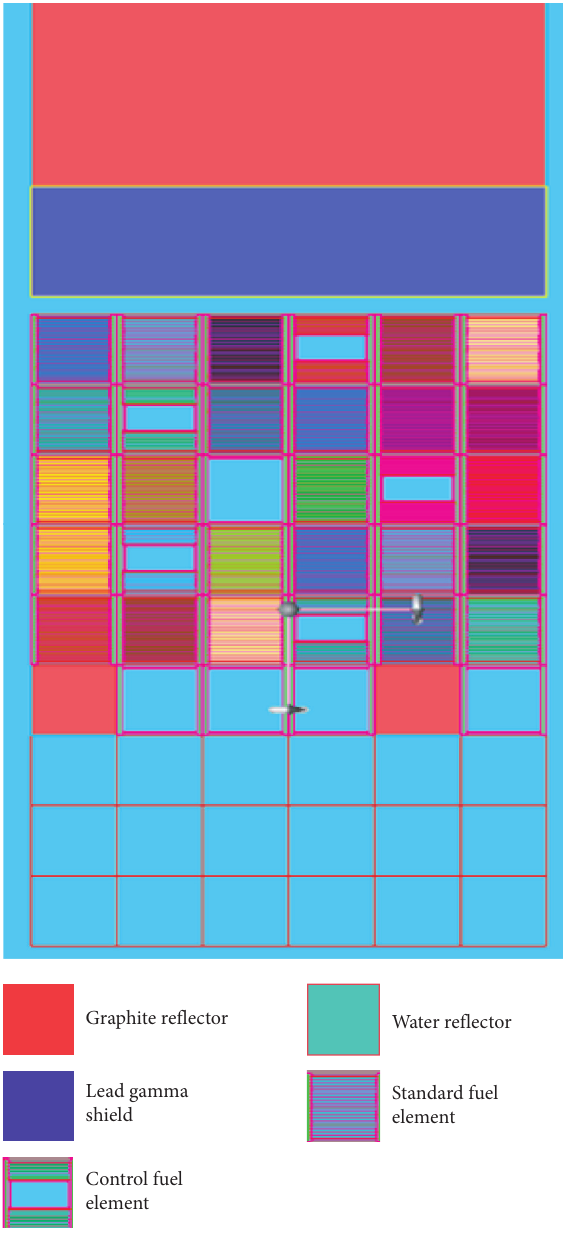
Figure 2: PARR-1 full-core configuration.